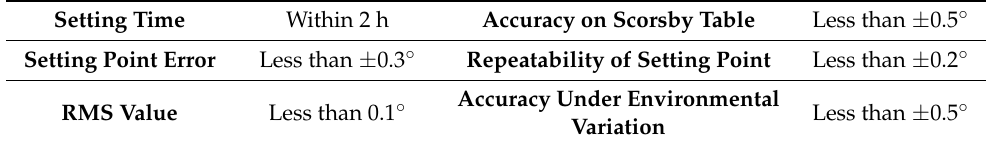
Table 4. Specifications of the TG-5000 gyrocompass.